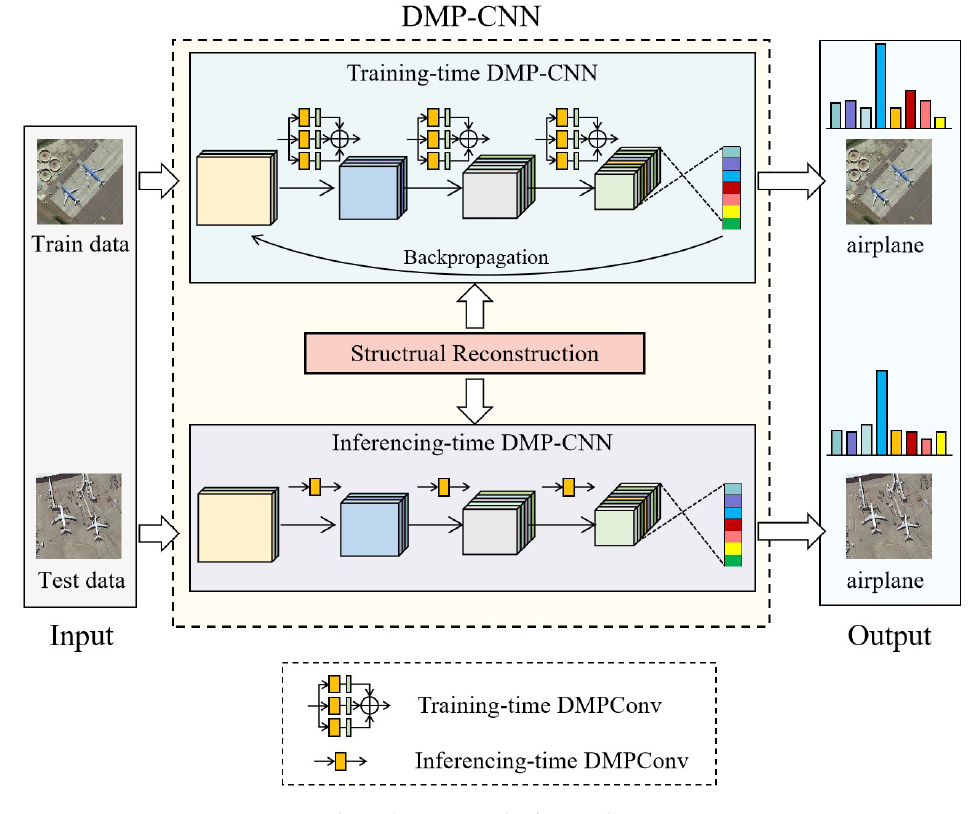
Figure 3. Framework of DMP-CNN.